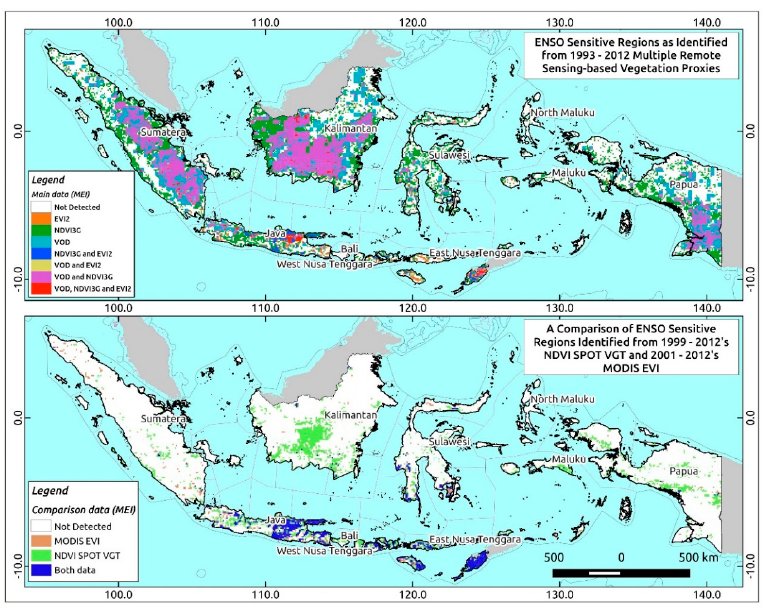
Figure 4. Distribution of ENSO-sensitive areas identified from primary data ( top ) show that NDVI3g and VOD agree for most of the area, while the distribution of sensitive regions from the primary and ancillary data show that EVI2 and MODIS EVI, respectively, share a similar pattern ( bottom ).